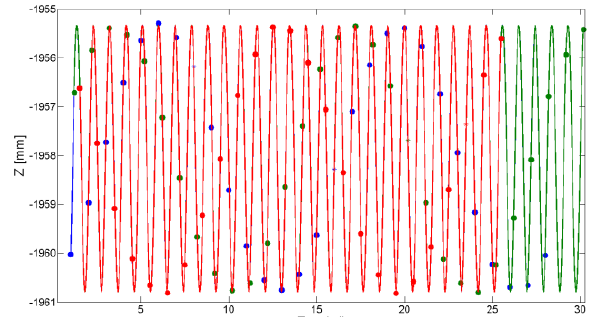
Figure 12. Example sampling density and recovered signal for the 3 Hz data (red, green and blue correspond to different bursts) This effectively increased the sampling rate of the camera system from 2.52 fps to 7.56 fps for the 1 Hz data, and from 2.87 fps to 8.61 fps for the 3 Hz data. This was